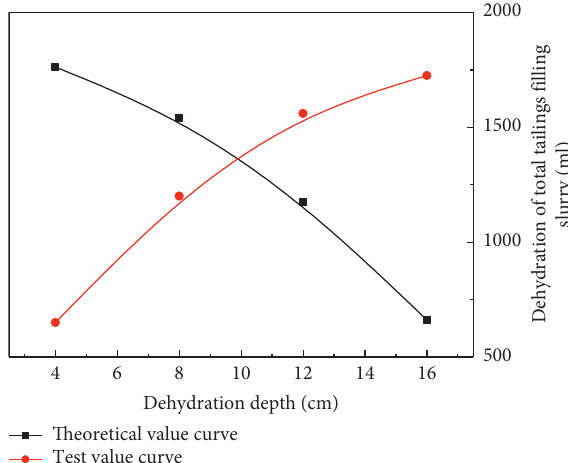
Figure 6: Comparison of the experimental values of the two groups with the theoretical